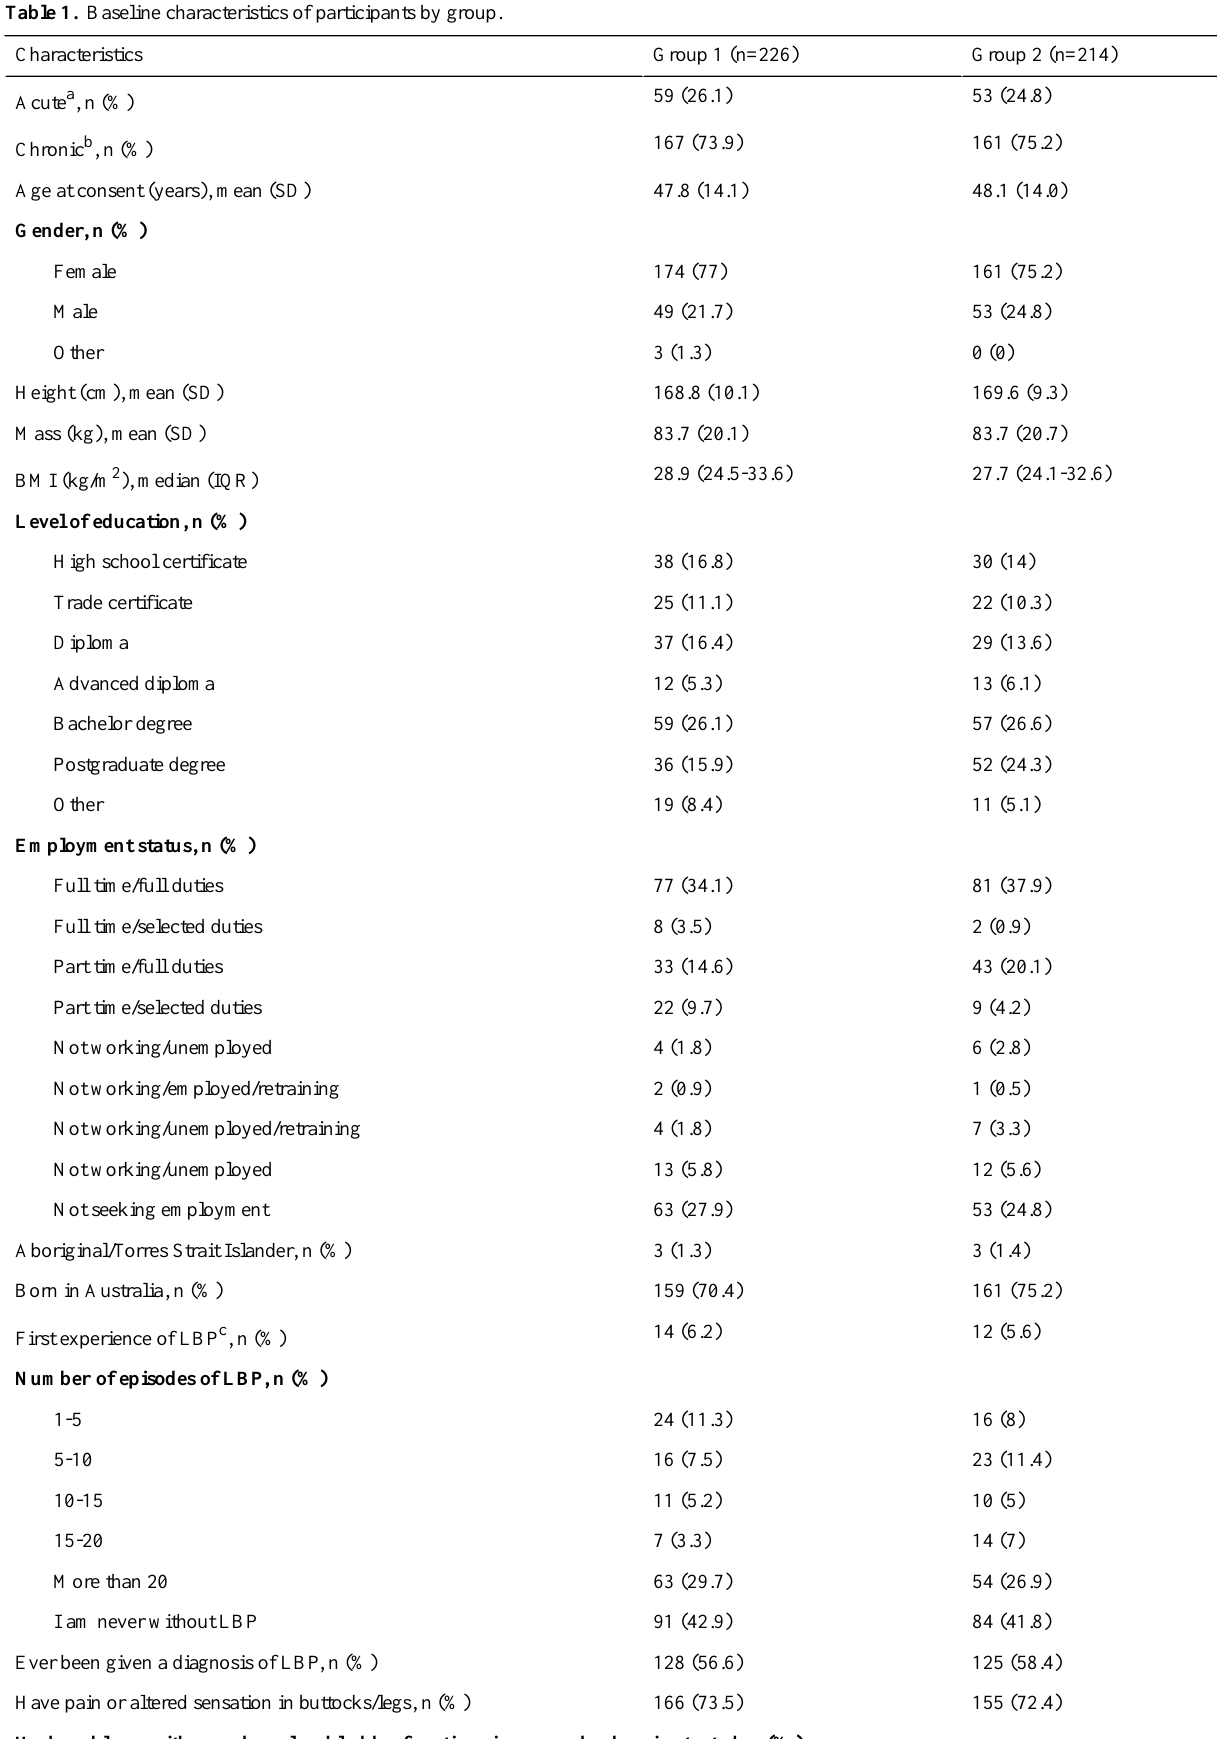
Table 1. Baseline characteristics of participants by